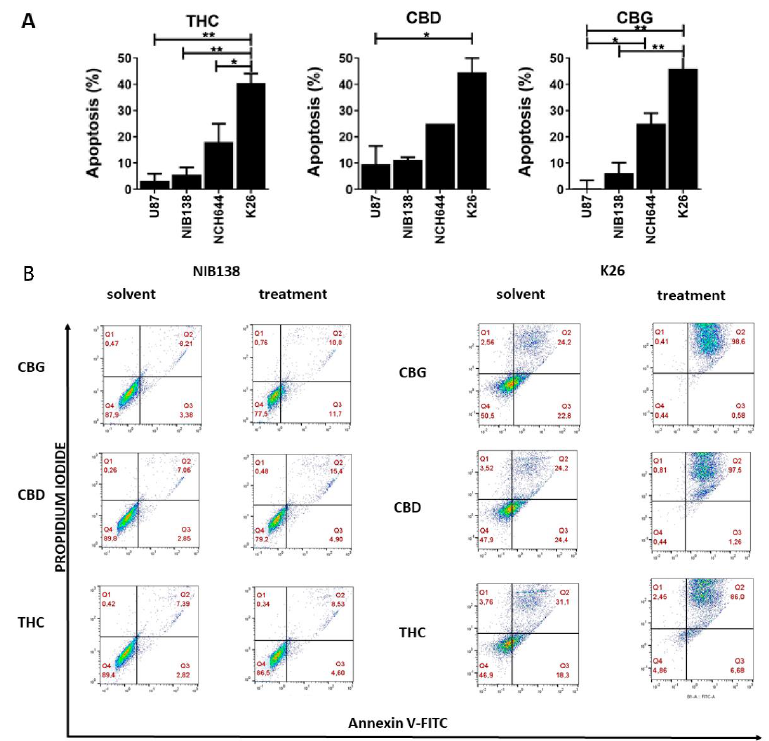
Figure 3. Apoptosis determination of GB and GSC cells by flow cytometry. The cells were treated with IC50 concentrations of CBG, CBD, and THC for 48 h. ( A ) The summary graphs represent the percentage of cells in early and late apoptosis after cannabinoid treatment (mean ± S.E.M.). ( B ) Cells were labelled with Annexin V-FITC (x-axis) and propidium iodide (PI) (y-axis) and analysed by flow cytometry as described in more detail in Material and Methods (Section 2.10.) The cell distributions based on cytometry analysis are presented for the GB cells NIB138 (left) and GSC line K26 (right) after CBG, CBD, and THC treatment. Additionally, such data for the established GB cells U87 and NCH644 are presented in Figure S2. Dot blots represent the results from one representative biological repeat. Error bars represent mean ± S.E.M. Statistical analyses were performed using GraphPad Prism software, using one-way ANOVA (* p < 0.05, ** p < 0.01).